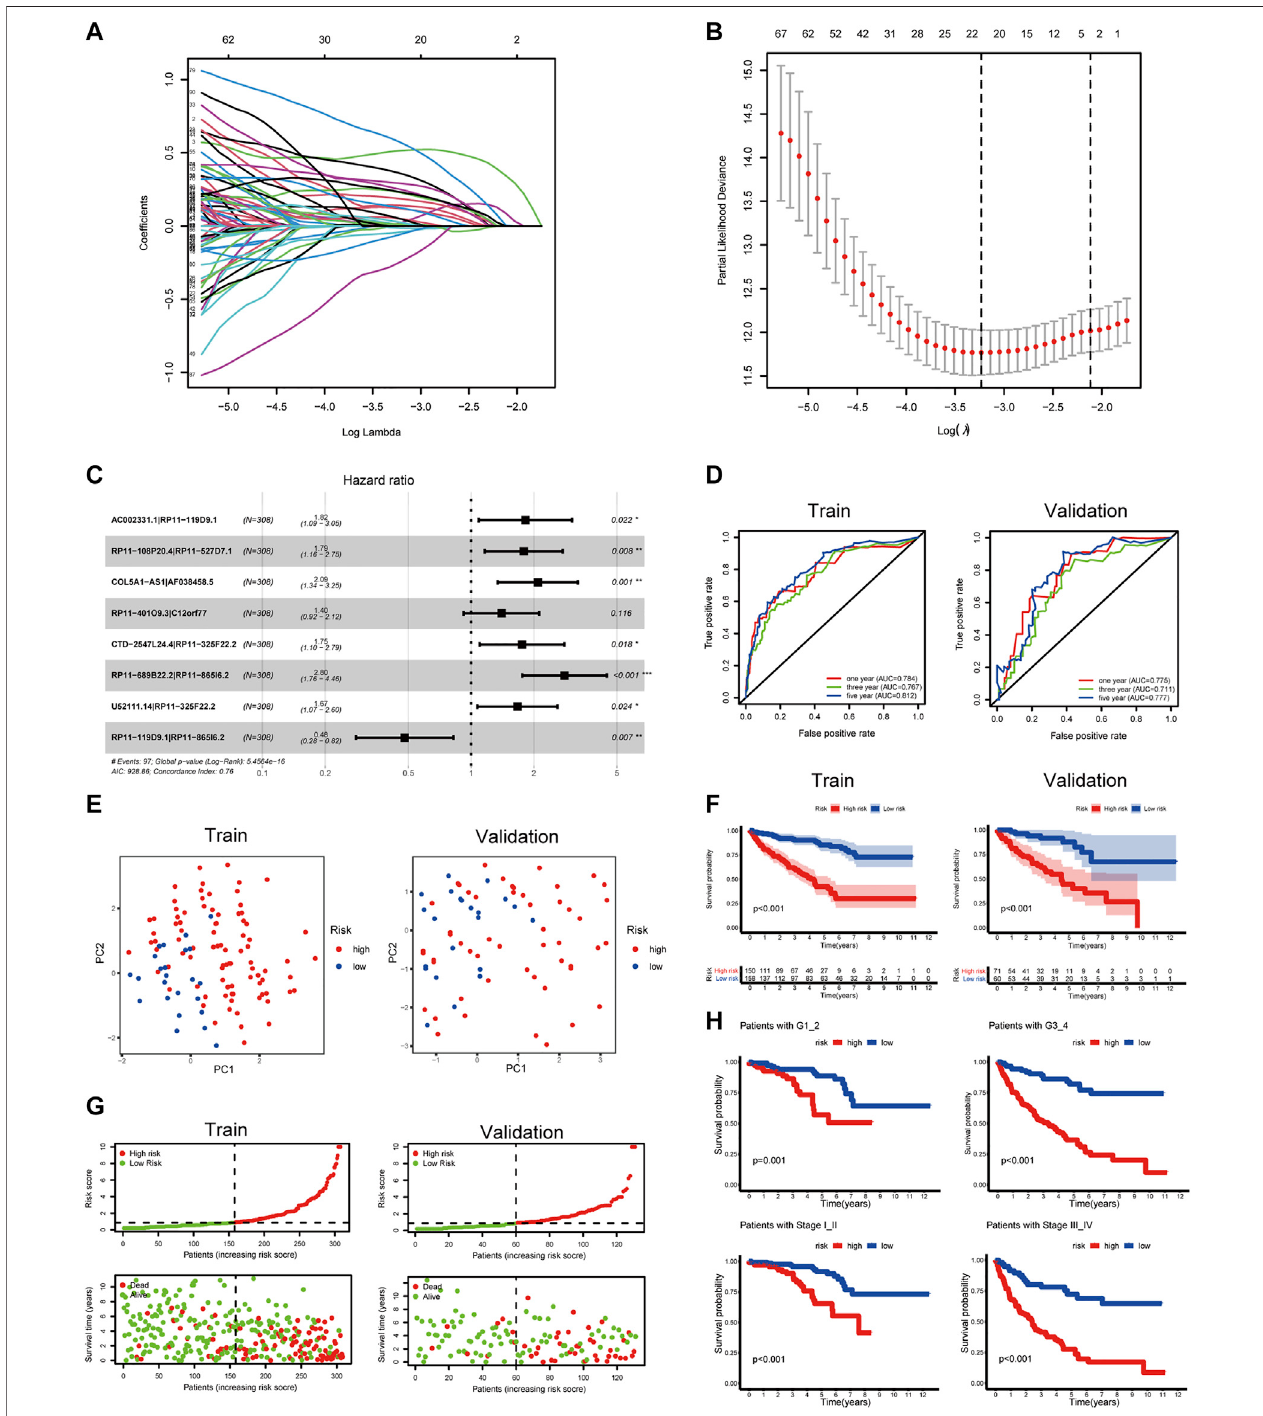
FIGURE6| ConstructionofaprognosticsignatureforccRCC. (A,B) LASSOcoef fi cientplotofPRlncRNAPs. (C) ForestplotsoftheeightOS-relatedPRlncRNAPs. (D) The ROC curve showed the diagnostic value of riskScore for the ccRCC prognosis. (E) PCA on the basis of prognostic characteristics. The red and blue dots, respectively, represented patients with high and low risk. (F) OS analysis of patients with high and low riskScore. (G) Distribution of riskScore and survival status of patients. (H) Survival curves of patients with the high- and low-risk groups in different grades and stages (*** p < 0.001, ** p < 0.01, * p < 0.05).